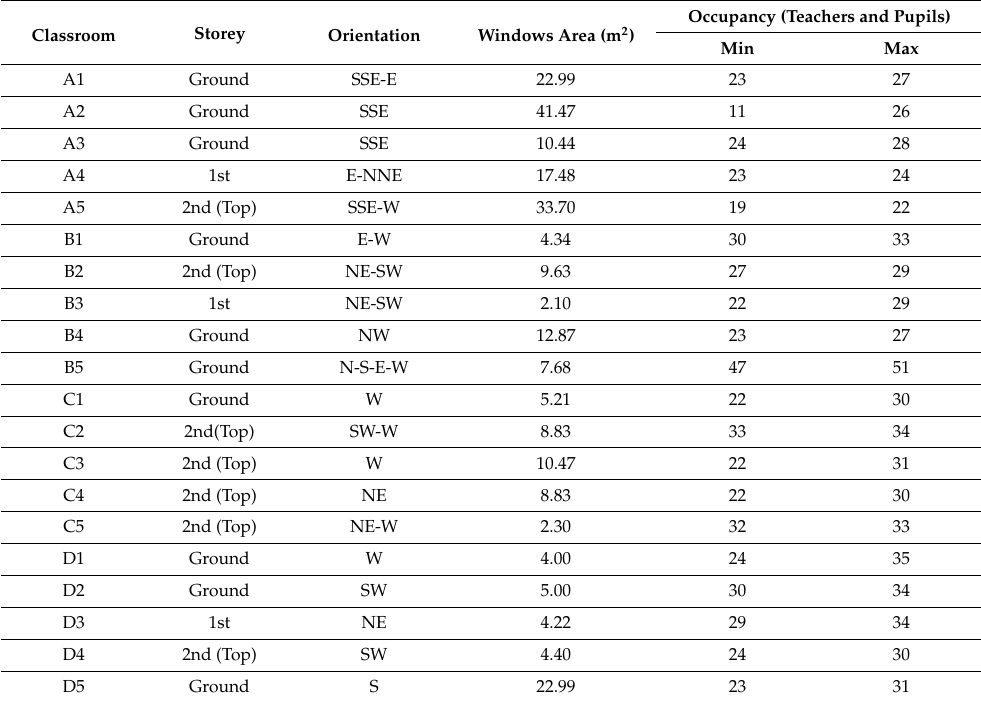
Table 2. Classrooms with orientation, location, occupancy and window surface